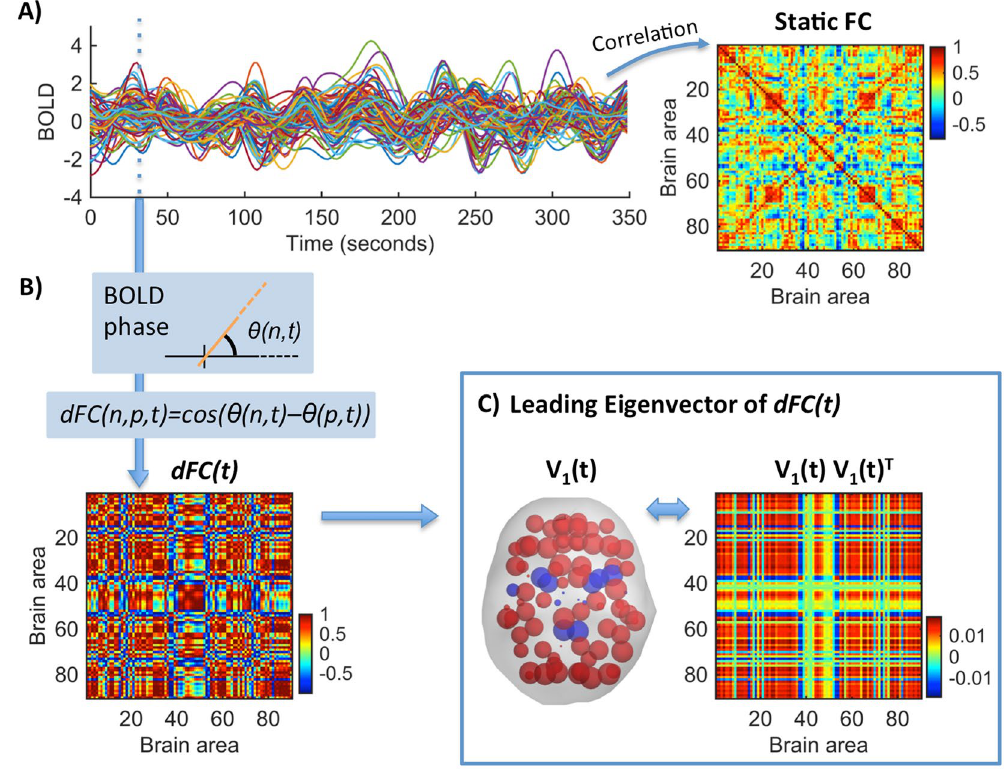
Figure 1. Time-resolved dFC and its Leading Eigenvector V 1 . ( A ) Resting-state BOLD signals from one subject at N = 90 brain areas. The traditional (static) FC matrix represents the correlation of BOLD signals over the whole recording time. ( B ) The dFC is obtained using BOLD Phase Coherence Connectivity 20 , such that each entry dFC(n , p , t) corresponds to the phase coherence between the BOLD signals in areas n and p at time t. At each time t , the dFC(t) is a symmetric NxN matrix. ( C ) The leading eigenvector, V 1 (t) , captures the dominant connectivity pattern of dFC(t) at time t . We illustrate this pattern in two ways: (Left) We use V 1 (t) to scale the size of spheres placed at the center of gravity of each brain area, coloring alike elements with the same sign. (Right) We plot the eigenvector’s outer product V 1 V 1T (see Methods - FC Leading Eigenvector